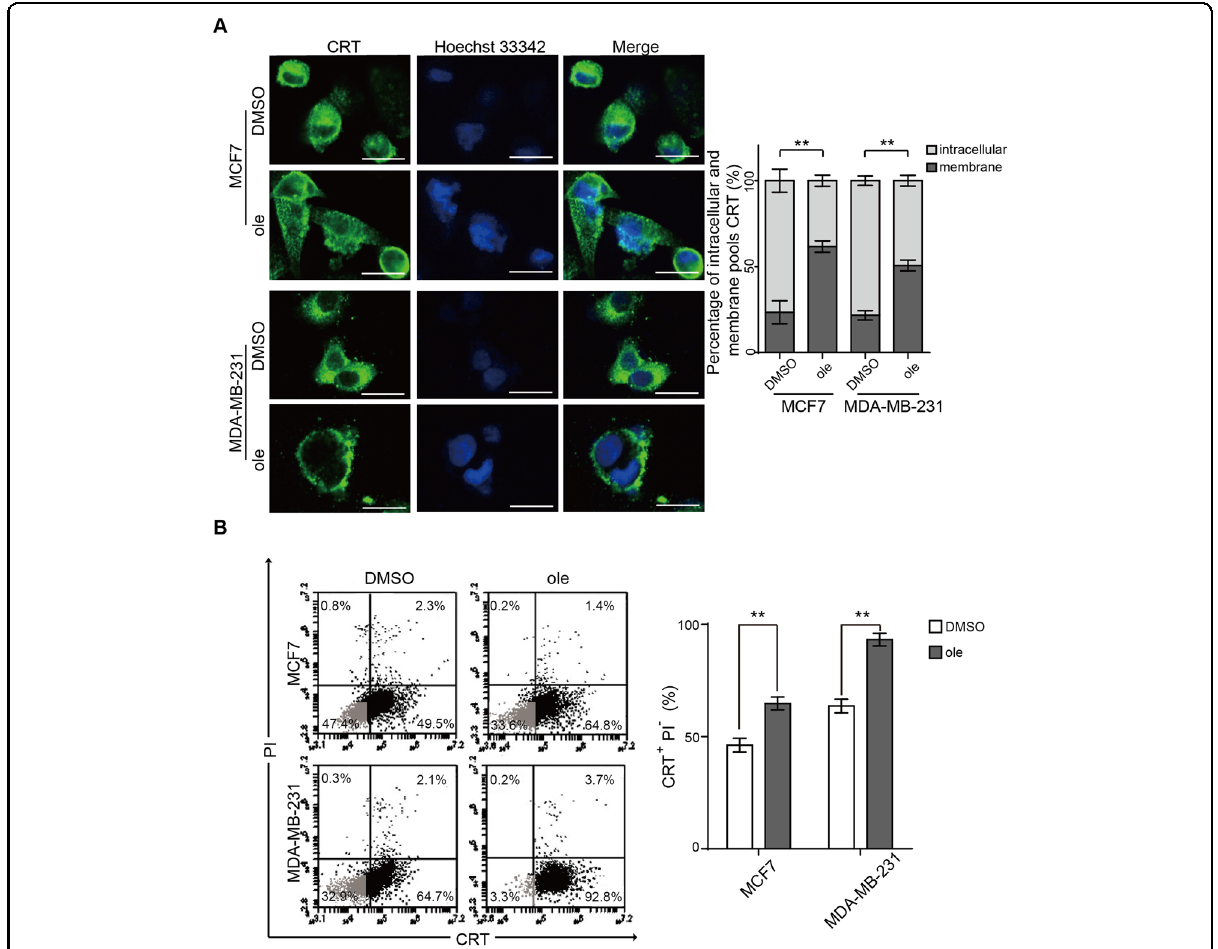
Fig. 1 Oleandrin induces CRT exposure in breast cancer cells in vitro. MCF7 and MDA-MB-231 cells were treated with oleandrin for 10 h. A Immuno fl uorescence analysis of cells stained with CRT and Hoechst 33342. Scale bar = 20 μ m. Intensities of the cell membrane and intracellular expressions of CRT were quanti fi ed with ImageJ software (Version 1.51j8) and plotted. B Cells were stained with CRT and PI, and detected by fl ow cytometry. The CRT-positive and PI-negative cells were showed in representative dot plots and quanti fi cation data. Data are presented as mean ± standard error of the mean from three independent experiments (* p < 0.05). ole,